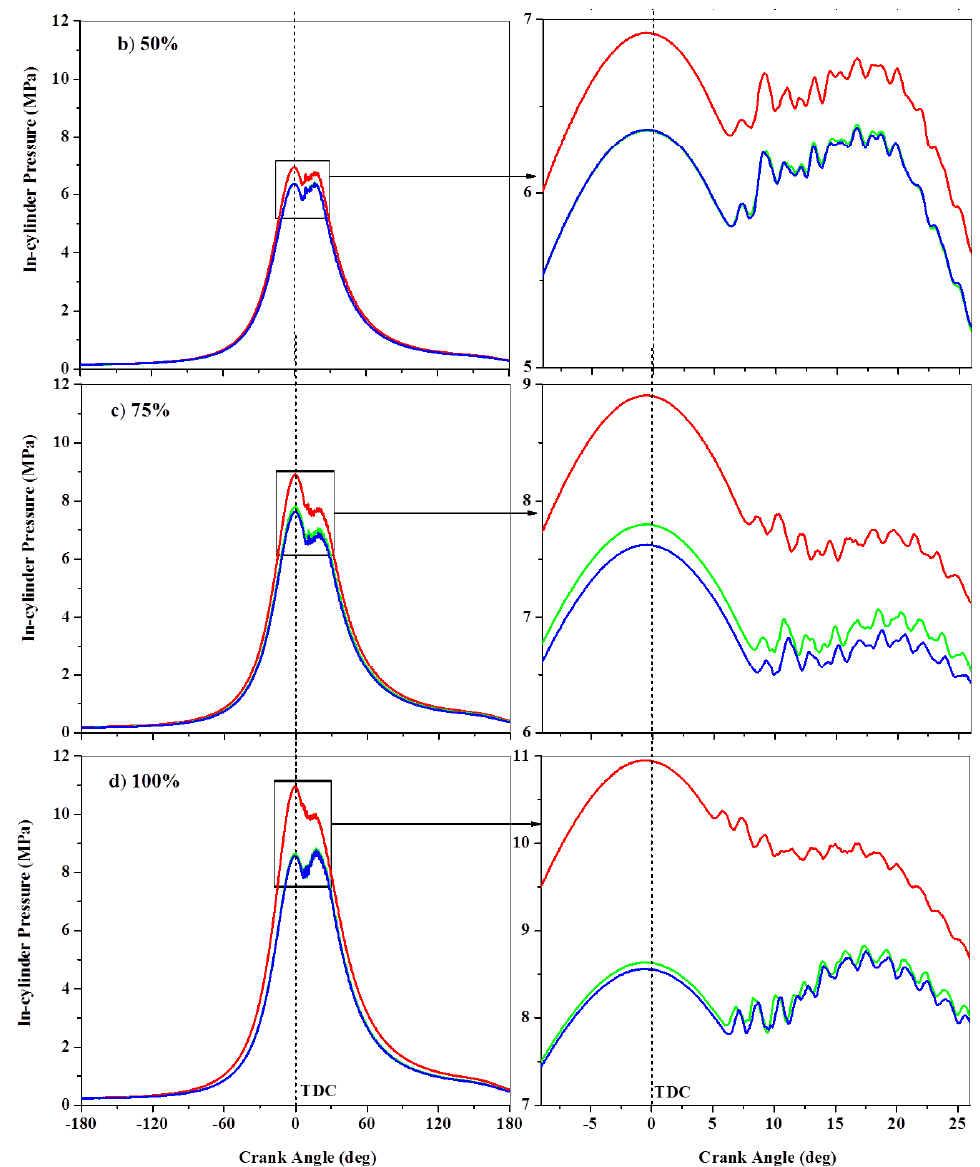
Figure 5. In-cylinder pressure with crank angle (CA) at four loads: ( a ) 25%; ( b ) 50%; ( c ) 75%, and ( d ) 100%.